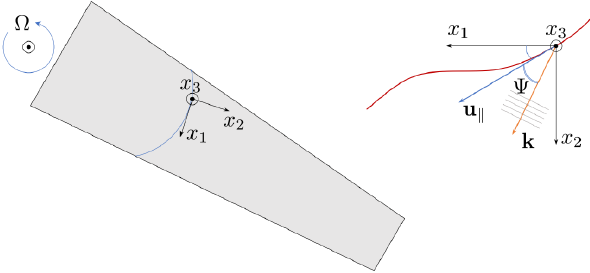
Figure 1. Coordinate system on the wind-turbine blade. (cid:127) is the rotation speed, u (cid:107) the mean-flow velocity vector projected in the x 1 – x 2 plane, k = ( α,β, 0) the wave vector, and (cid:57) the perturbation propagation angle relative to the outer